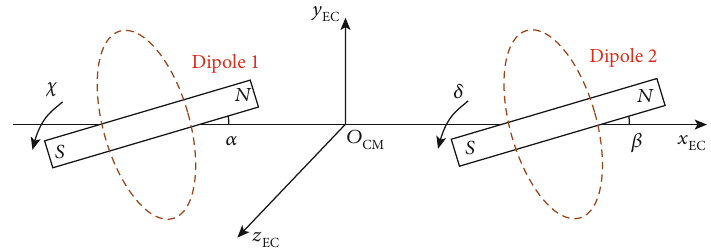
Figure 3: Relative position and attitude between two dipoles.